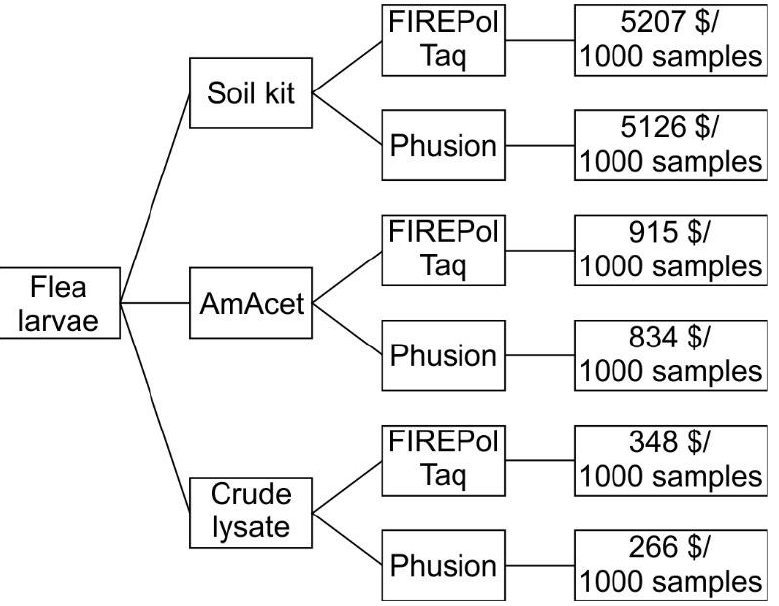
Figure 2. DNA preparation and PCR methods evaluated. Three methods were used to obtain DNA from flea larvae, including a soil DNA isolation kit (S-kit), an ammonium acetate precipitation protocol (AmAcet), and a crude flea lysate protocol. Samples from all extraction protocols were used for PCR amplification using either a hot-start FIREPol ® Taq DNA polymerase or the highly inhibitor-resistant Phusion ® HF DNA polymerase.